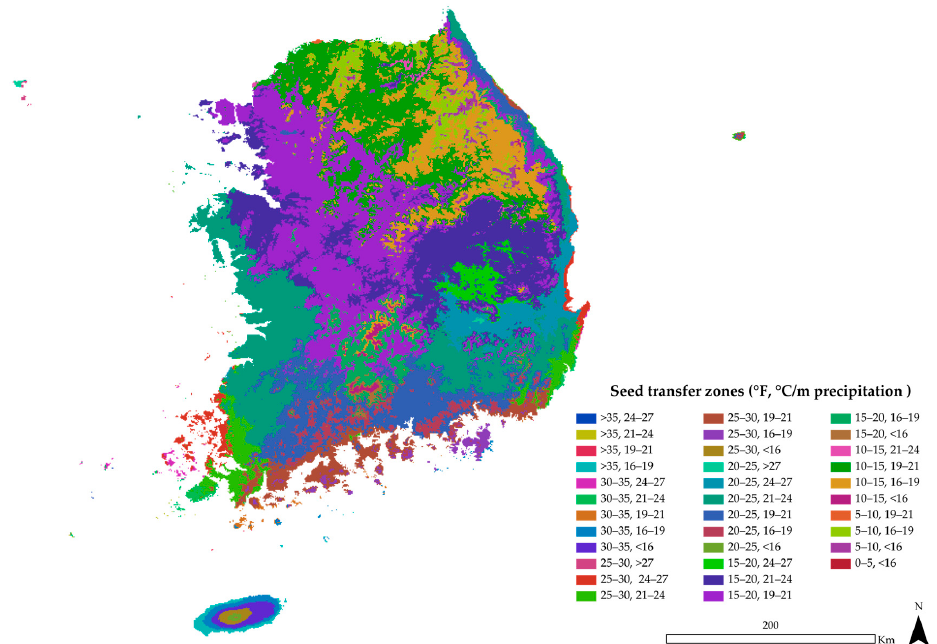
Figure 5. Seed Transfer Zones in South Korea (34 zones).